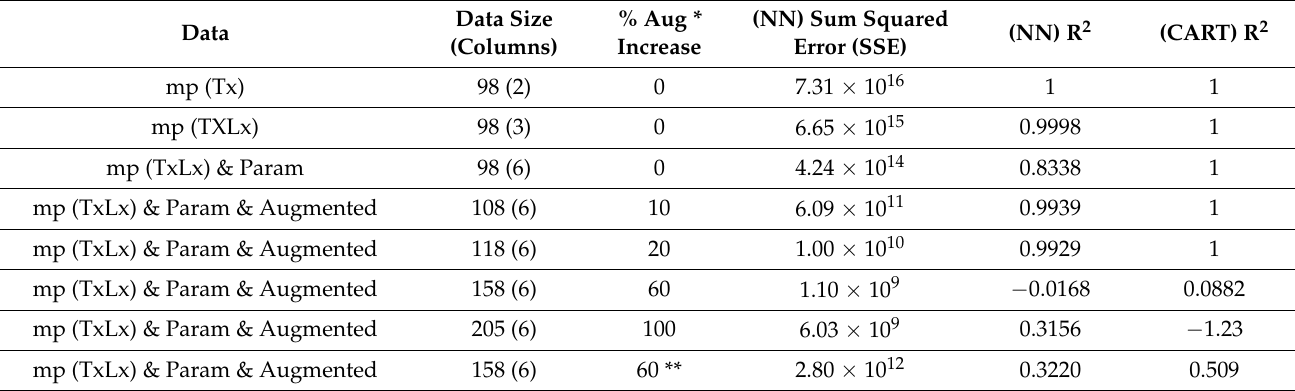
Table 4. Comparison metric results for NN and CART techniques using different levels of data